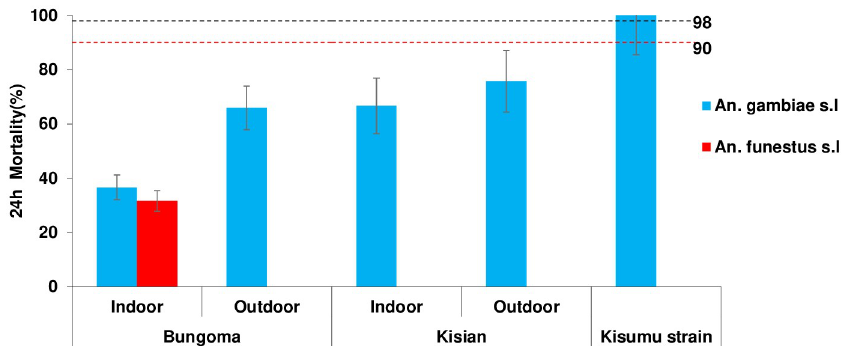
Fig 3. Mortality rates of indoor and outdoor resting Anopheles gambiae s.l and An . funestus F1 progeny in standard WHO tube bioassays after exposure to 0.05% deltamethrin test papers and 24 hr recovery period. Dotted lines represent upper (98%) and lower (90%) cut-offs for WHO classifications; values above the upper line indicate susceptibility and values below the lower red line indicate resistance (WHO, 2016). Error bars for the mean are shown.